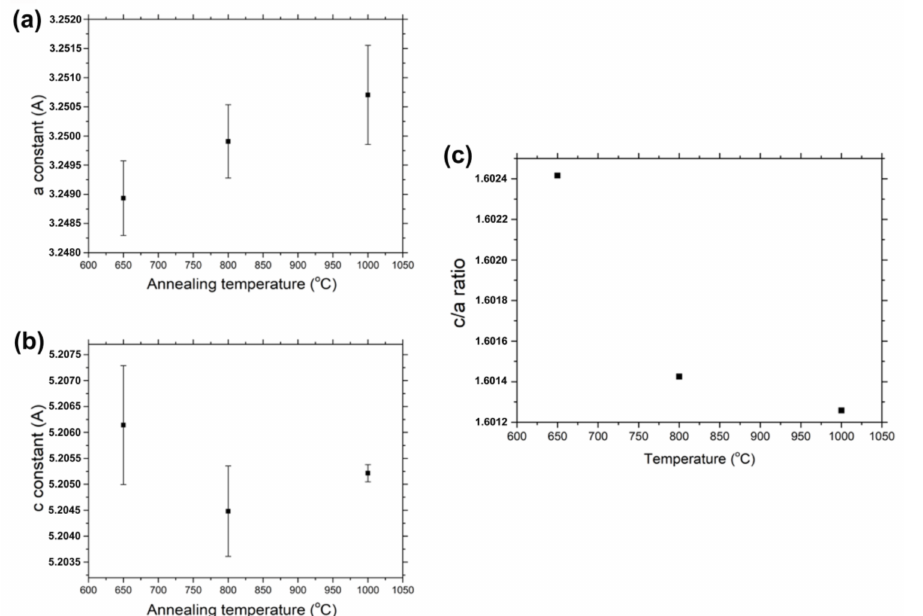
Figure 4. ( a ) A-constant of samples annealed at 650, 800, and 1000 ◦ C; ( b ) c-constant of samples annealed at 650, 800, and 1000 ◦ C; ( c ) c/a ratio of samples annealed at 650, 800, and 1000 ◦